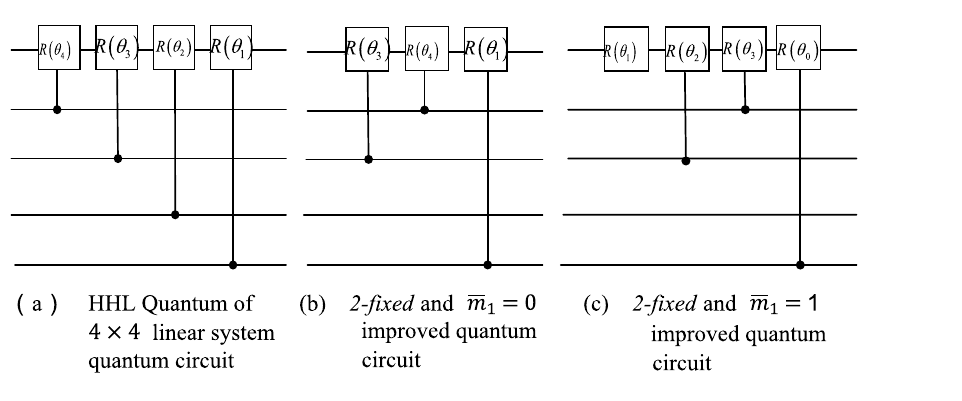
Figure 5. AQE part of the original circuit and the improved